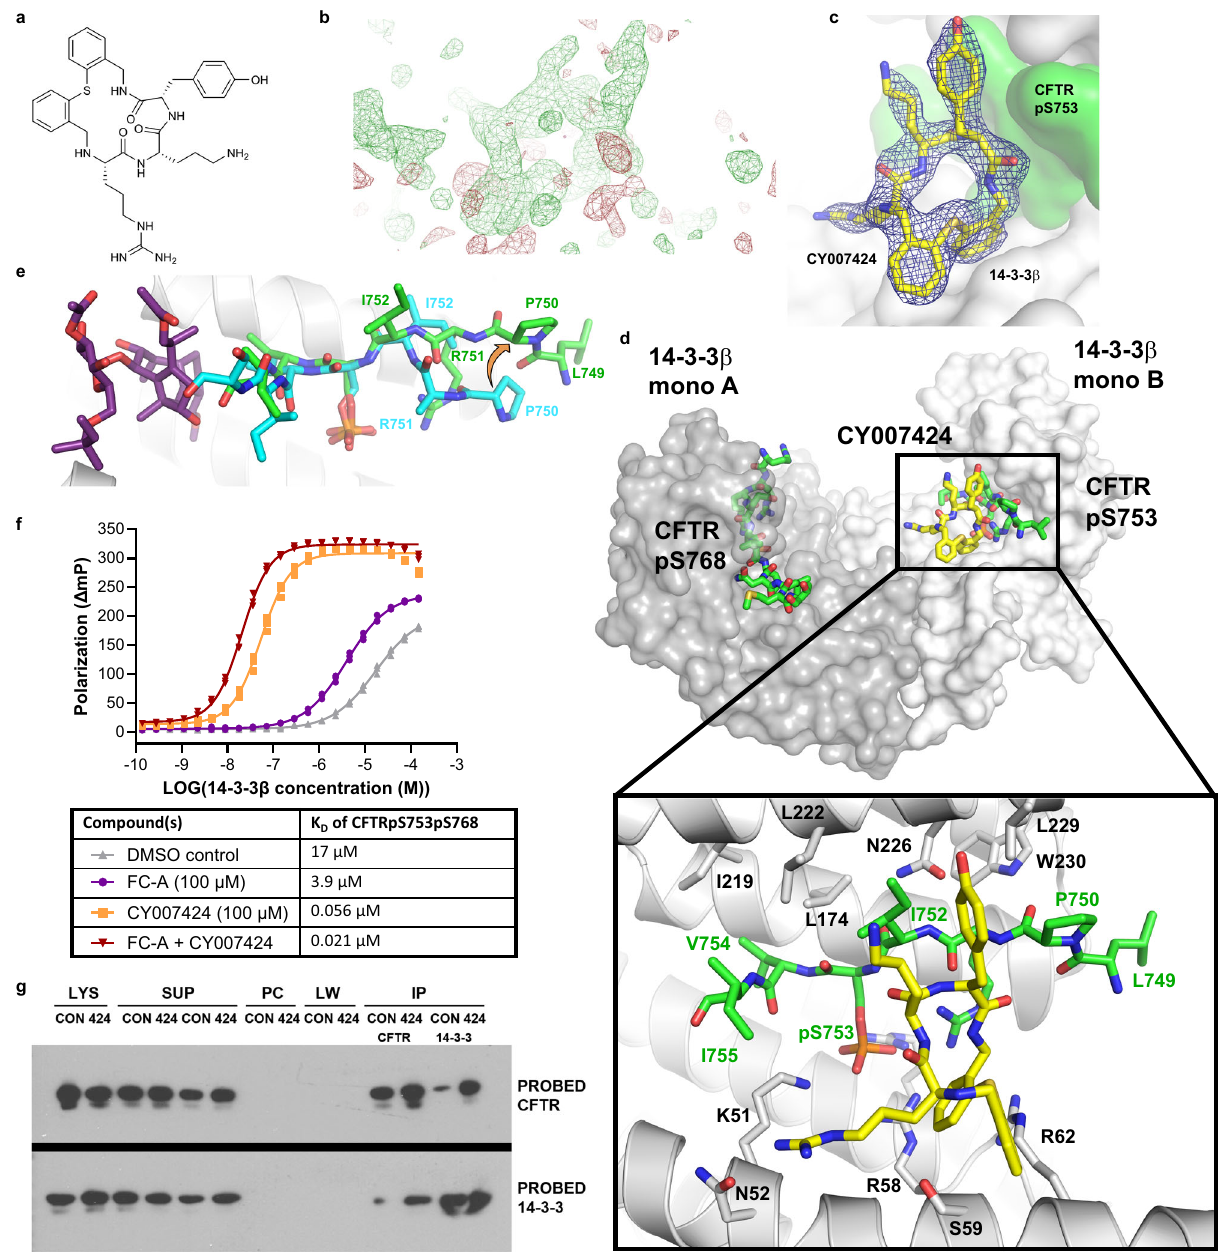
Fig. 3 Macrocycle stabilization of the 14-3-3/CFTR interaction. a Chemical structure of CY0072424. b Electron density map (unbiased Fo-Fc, 2.5 σ , directly after molecular replacement) of CY007424 bound to the interface of 14-3-3 β and CFTRpS753. c Final 2Fo-Fc electron density map (1 σ ). d Crystal structure of the 14-3-3 β homodimer complexed with CFTRpS753pS768 and CY007424 (PDB ID: 7QI1). e Overlay of the CFTRpS753 peptide motif bound to 14-3-3 in the presence of FC-A (cyan sticks) or CY007424 (green sticks). FC-A is shown as purple sticks. f FP assay of FITC-labeled CFTRpS753pS768 (10 nM) with 14-3-3 β in the presence of 100 μ M of FC-A, CY007424, or both compounds. Background polarization was subtracted from all values, n = 3 technical replicates. g Immunoprecipitation study to show the effect of CY007424 on the interaction between of CFTR and 14-3-3 proteins. CFTR and separately 14-3-3 immunoprecipitation from HEK293 cells expressing F508del-CFTR after 24 h of CY007424 (10 μ M) (424) or vehicle alone (CON). LYS: cellular lysate prior to preclear, SUP: supernatant after speci fi c bead incubation, PC: second preclear, LW: last wash after the immunoprecipitation IP are the speci fi c antibody beads. IP, upper blot: probed with CFTR AB, lower blot: probed with 14-3-3 AB. Source data are provided as a Source Data fi binding to 14-3-3 (Fig. 3g), while CY007491 and CY007476 — which CY007424 show an additive effect on CFTR function in the cell are inactive in the ion transport assay — did not enhance binding of membrane (Fig. 5c). Another cellular assay was performed with the 14-3-3 during the co-immunopreciptitation (Supplementary Fig. 4). Ussing Chamber, which detects and quanti fi es transport of ions When the cells were incubated with the CFTR inhibitor 172 across epithelial tissue 22 . F508del-CFTR expressing cystic fi brosis epithelial (CFBE) cells were treated for 18 h with 20 μ M CY007424. (INH172) the effects in this assay were neutralized, demonstrating After forskolin and genistein stimulation, the short-circuit current CFTR-dependency of the signal increases (Fig. 5c). Interestingly, the of the cells was measured. The CY007424-treated CFBE cells combinations of VX-809 and CY007424 and Trikafta ® and